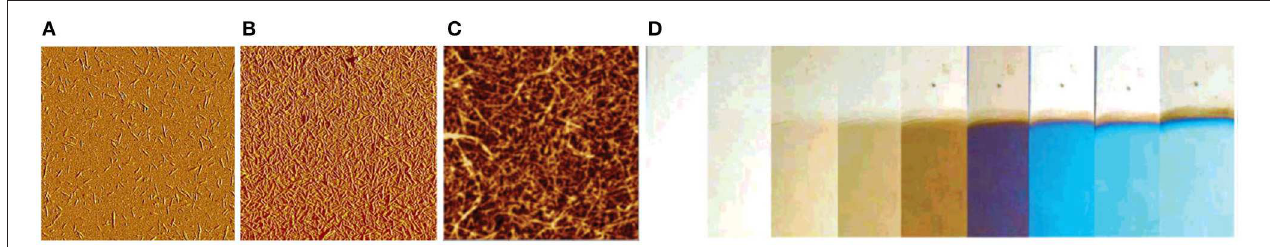
FIGURE 9 | (A) AFM image of spin coated submonolayer of CNCs on TiO 2 , 5 × 5 µ m 2 scan (Reproduced from Kontturi et al., 2007 with permission from American Chemical Society); (B) AFM image of spin coated layer of CNCs with full coverage, 5 × 5 µ m 2 scan (Reproduced from Kontturi et al., 2007 with permission from American Chemical Society); (C) AFM image of LbL deposited CNF film, 1.5 × 1.5 µ m 2 scan (Reproduced from Wågberg et al., 2008 with permission from American Chemical Society); (D) photograph of LbL deposited CNF films of different thickness values, resulting in colored structures through optical interference (Reproduced from Wågberg et al., 2008 with permission from American Chemical